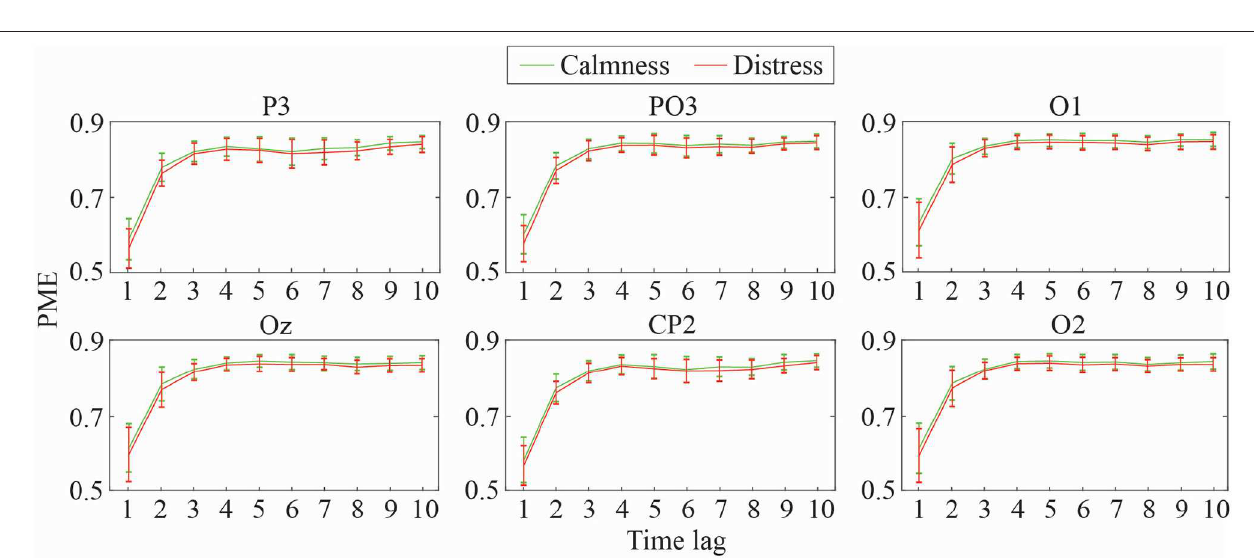
FIGURE 3 | Mean and standard deviation values of PME at different time-lags for calmness and distress at the most significant EEG channels.